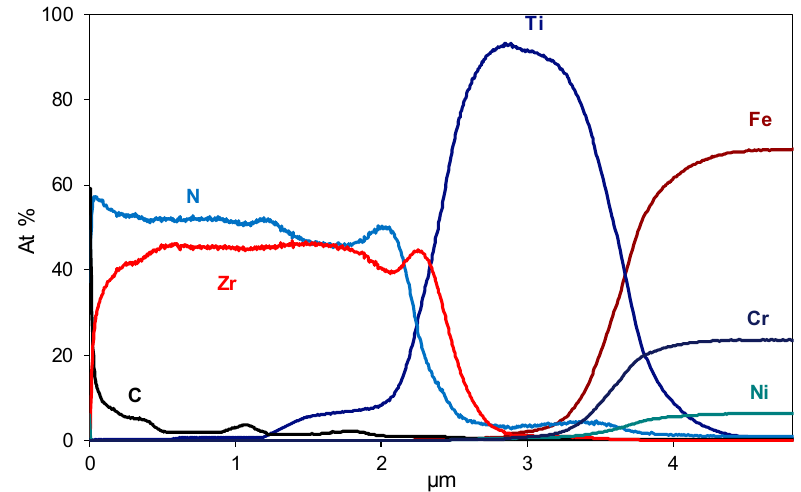
Figure 8. D1 design coating composition graphic obtained by GD-OES.